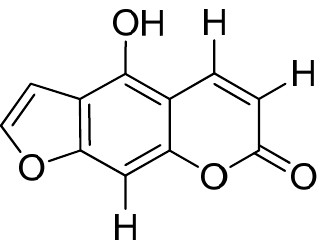
Figure 1. Chemical structure of